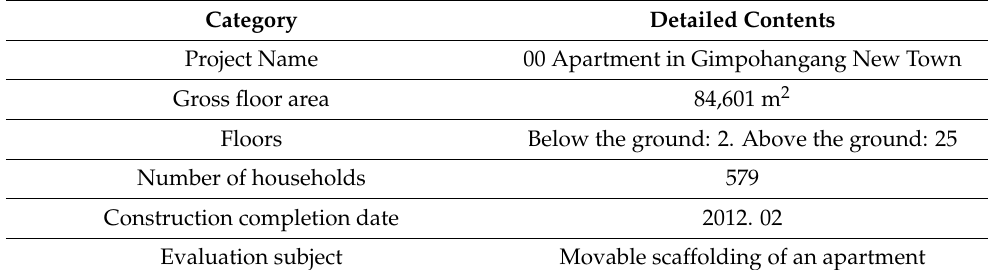
Table 5. Case project